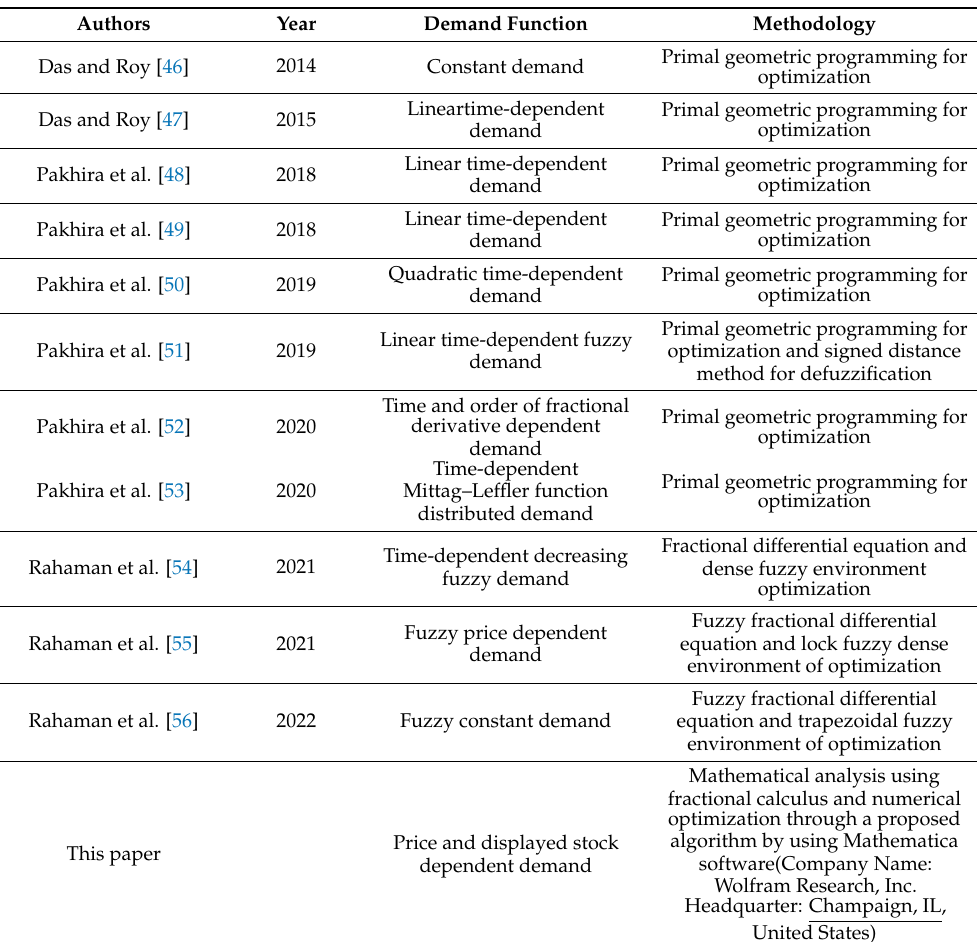
Table 1. Comparison among the contributions of recent publications related to the proposed fractional inventory